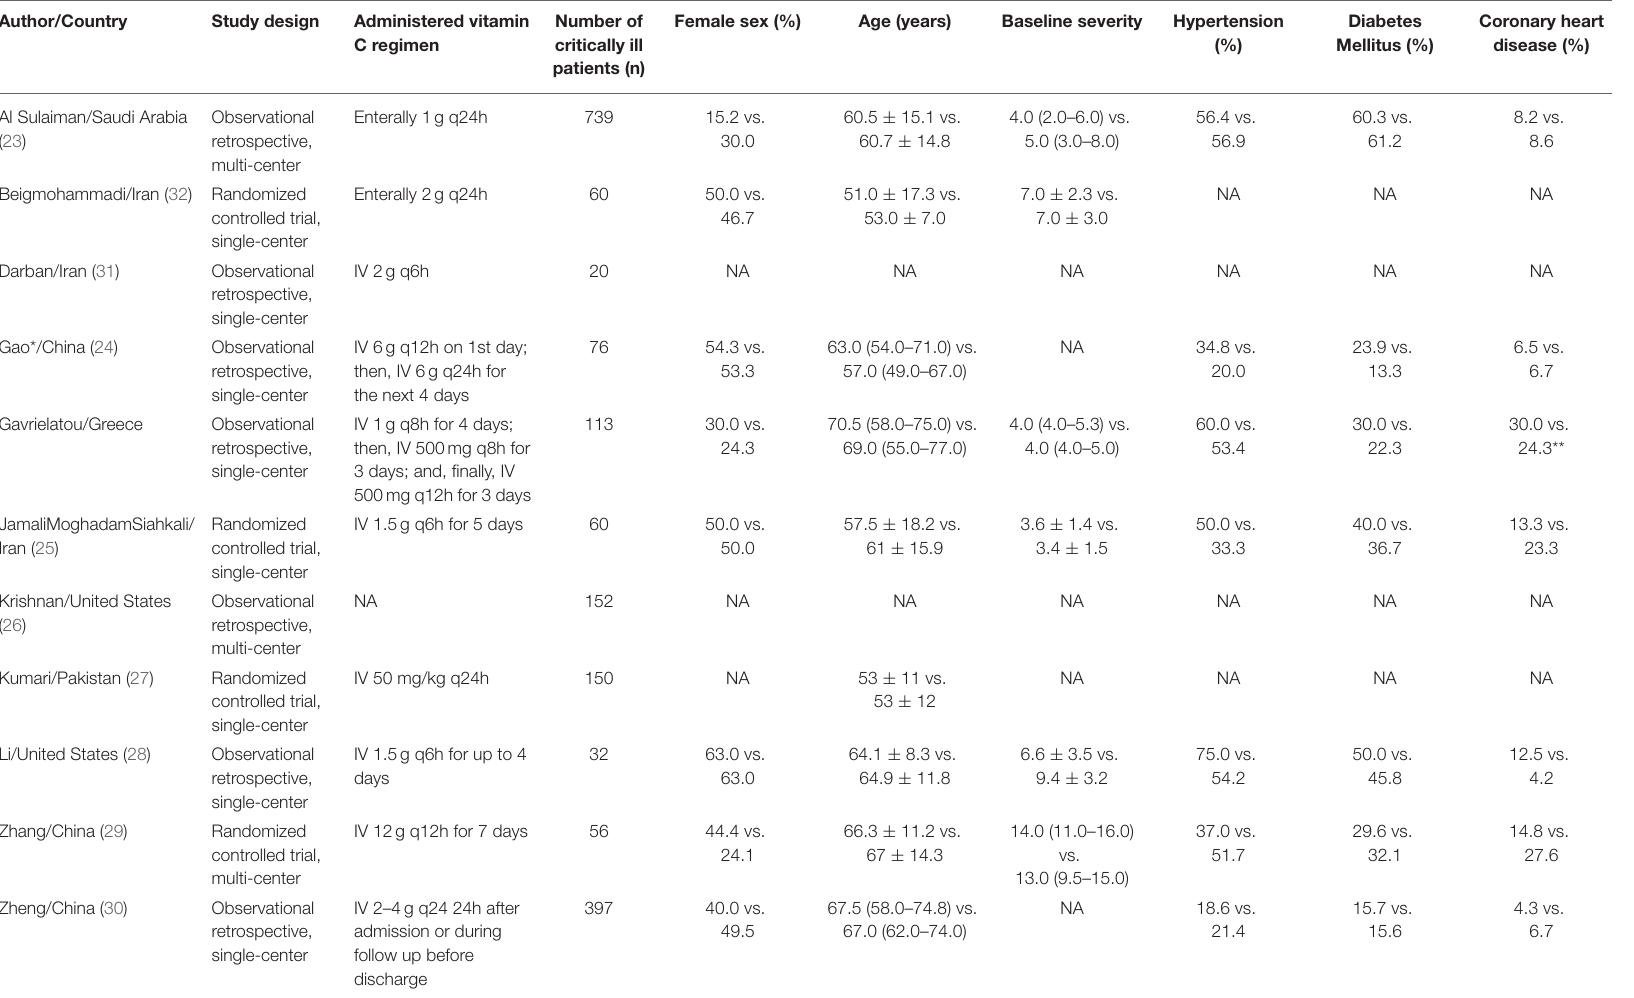
TABLE 3 | Characteristics of individual studies included in the meta-analysis comparing vitamin C vs.